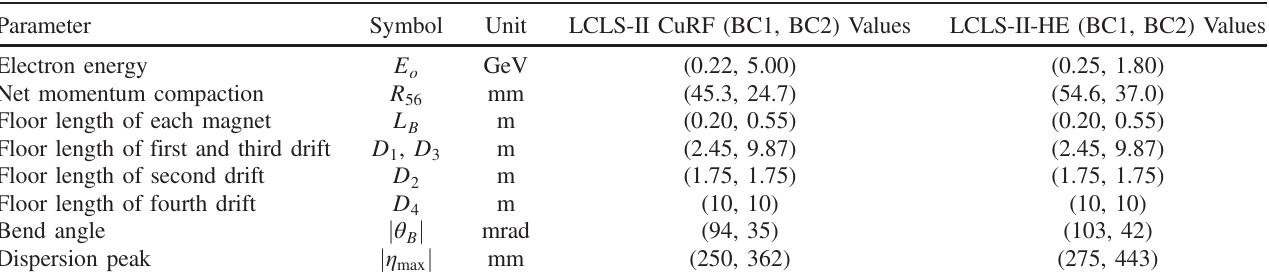
TABLE II. LCLS-II CuRF and LCLS-II-HE BC1 and BC2 4-Bend chicane settings.